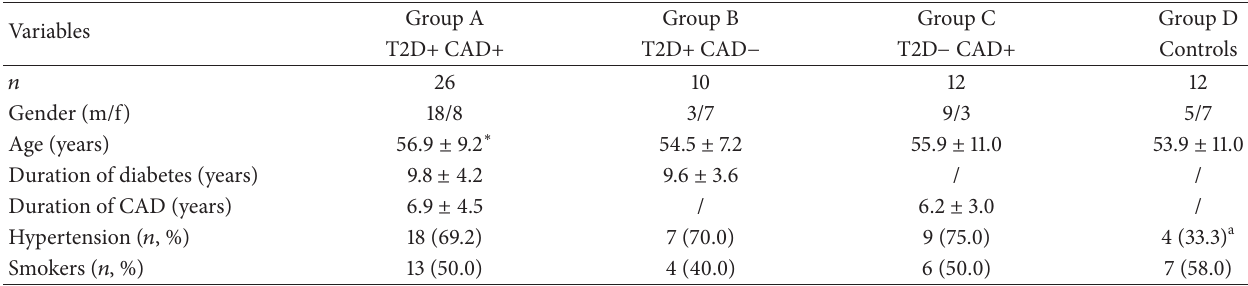
Table 1: Patient characteristics.